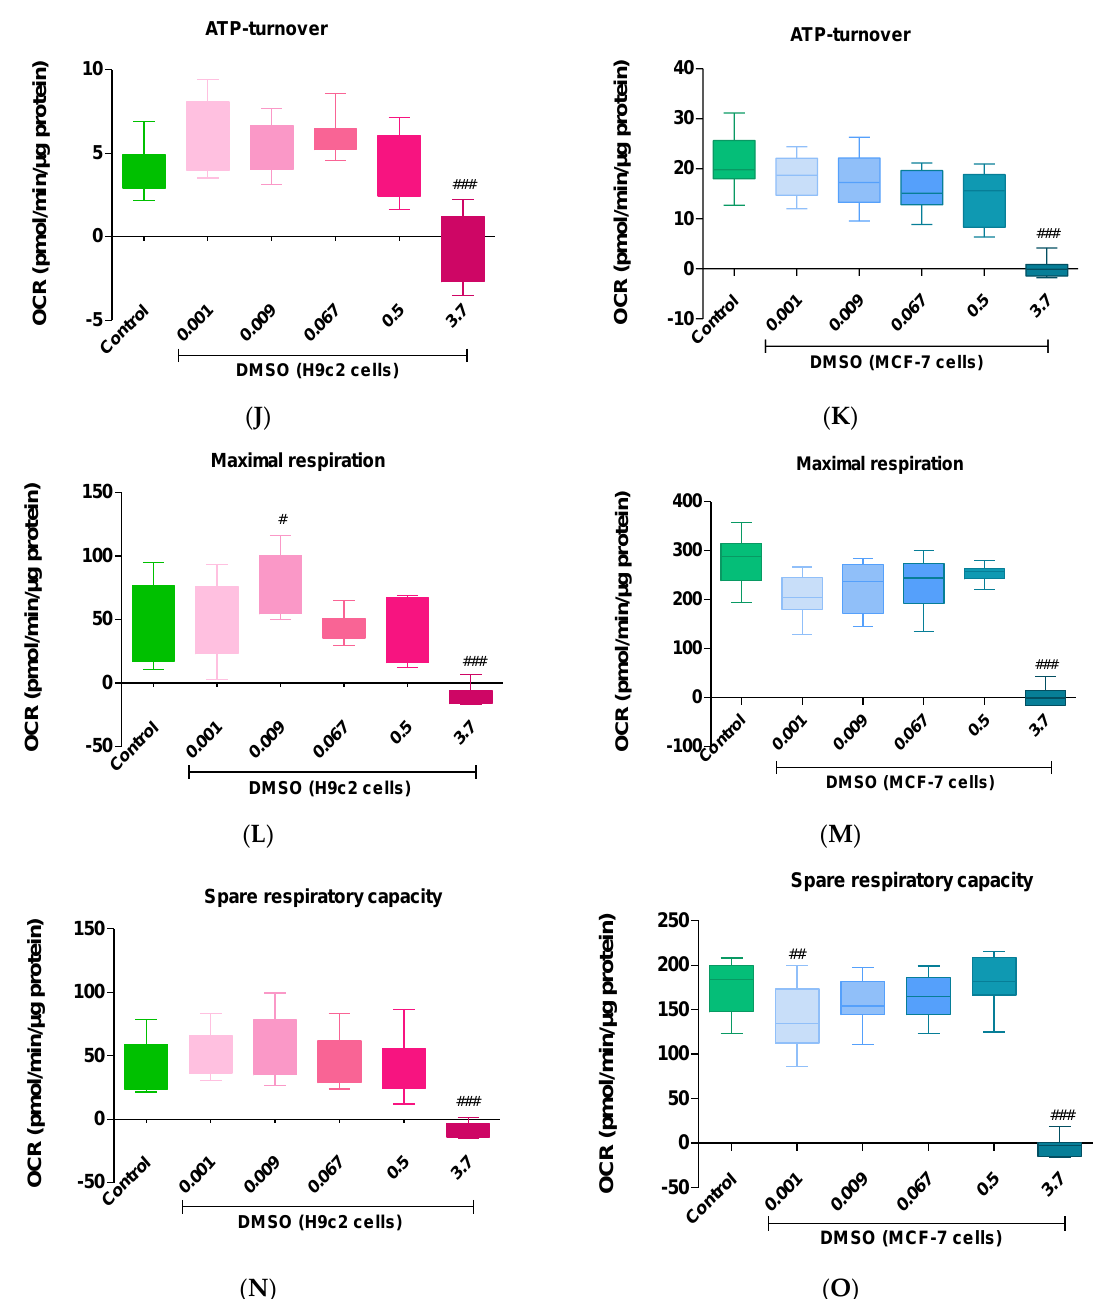
Figure 2. The effect of dimethyl sulfoxide (DMSO) on the mitochondrial bioenergetics in H9c2 cardiomyoblasts and MCF-7 breast cancer cells. ( A ) Energy phenotype, ( B , C ) Oxygen consumption rate (OCR), ( D , E ) extracellular acidification rate ( ECAR ), ( F , G ) basal respiration, ( H , I ) ATP-linked respiration, ( J , K ) ATP turnover, ( L , M ) maximal respiration and , ( N , O ) spare respiratory capacity . Both cell lines were treated every second day for 6 days with varying DMSO concentrations (0.001, 0.009, 0.067, 0.5, and 3.7%). Data are presented as the mean ± SEM of 3 biological experiments with 8 technical repeats ( n = 3). Significance is indicated as # p < 0.05, ## p < 0.01, and ### p < 0.001 versus the control. Table 1. Respiratory flux ratios of DMSO treated H9c2 cells.